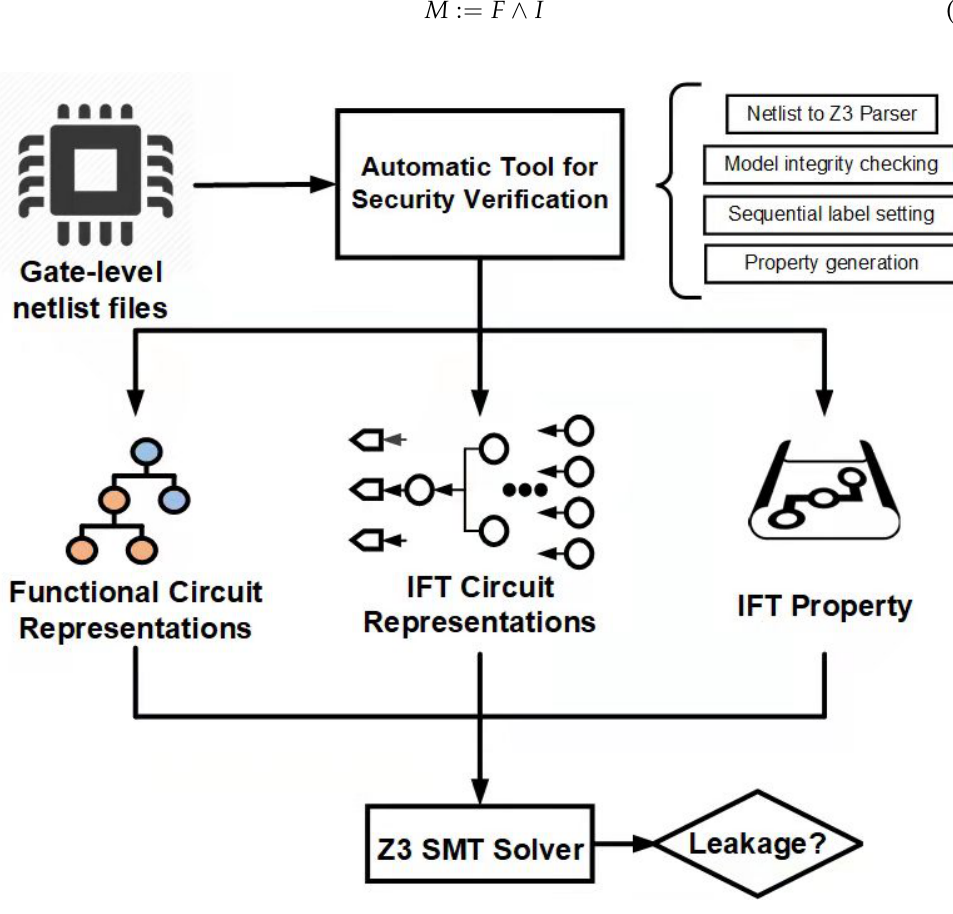
Figure 3. Working procedure of the proposed formal